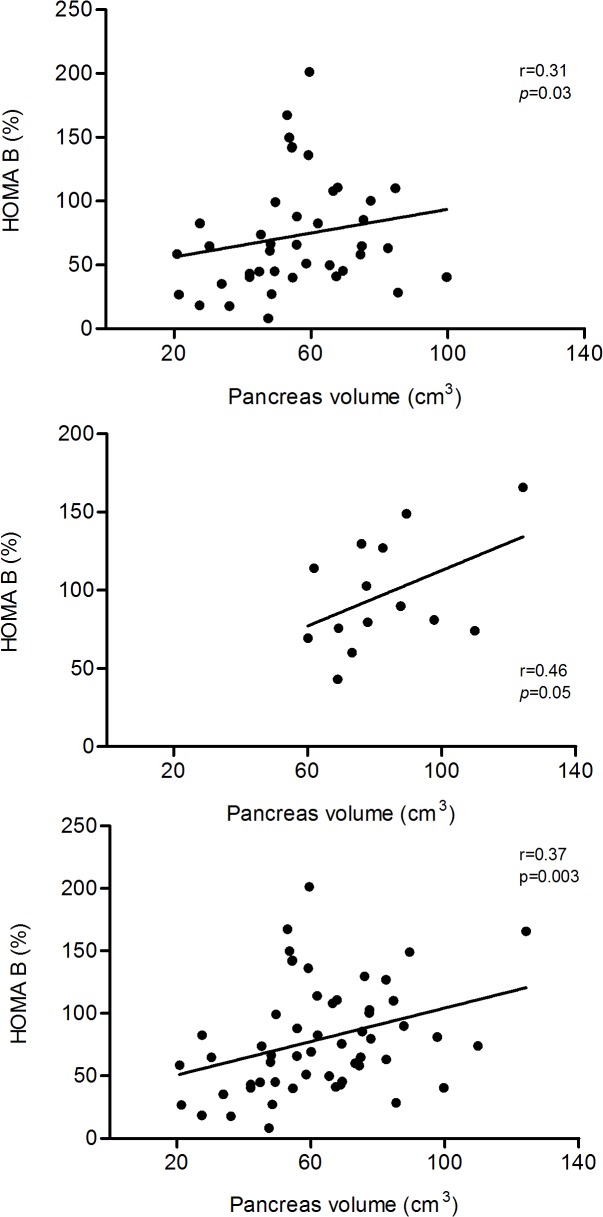
Relationships between HOMA-β (%) and pancreas volume (cm3) in T2DM group (panel a), control group (panel b) and all subjects combined (panel c).In each case there was a positive correlation between pancreas volume and insulin secretion (Spearman test).